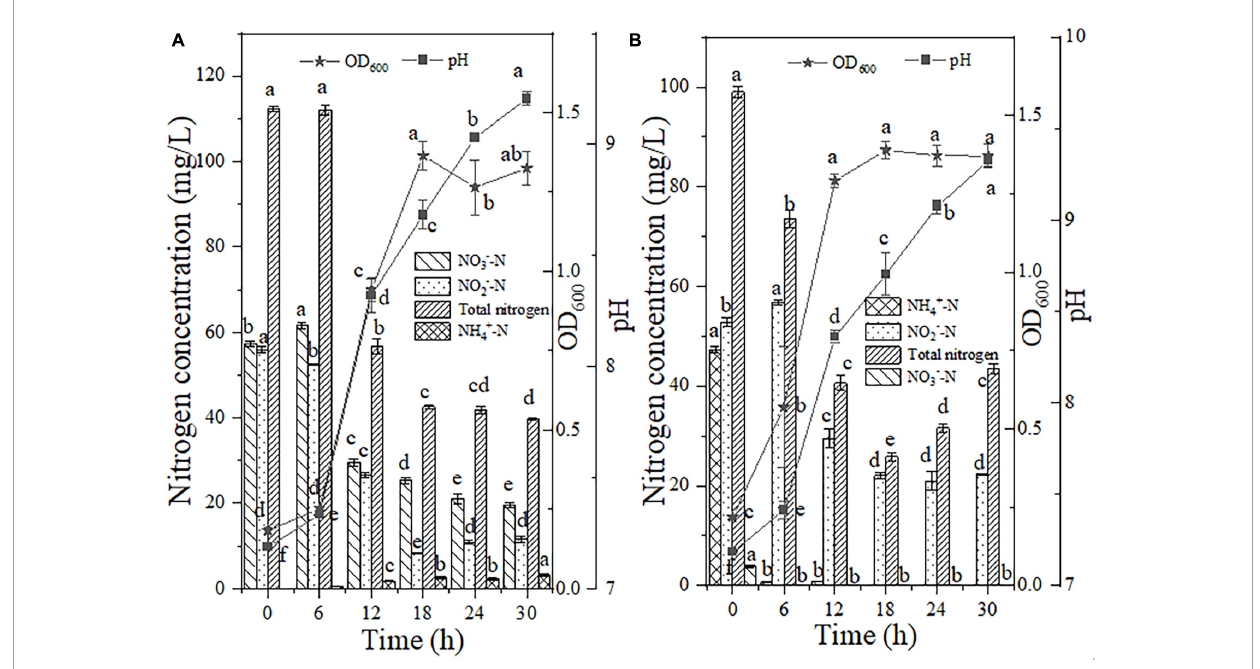
FIGURE6 The effects of nitrite (NO 2 − -N) on HN-AD. (A) Nitrate (NO 3 − -N); (B) ammonium (NH 4 + -N). Different letters represent significant differences between treatments ( p <